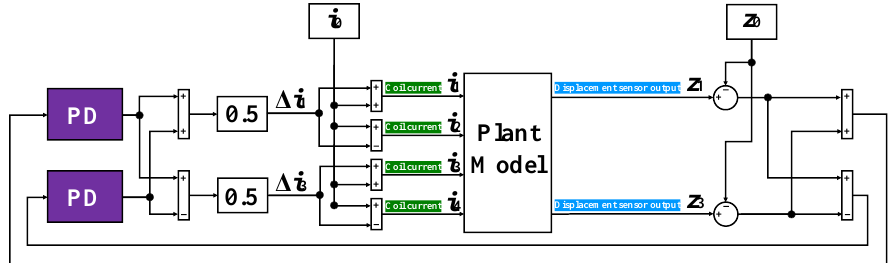
Figure 9. Control Figure 9. Control diagram. Table 4. The designed PD-gains.